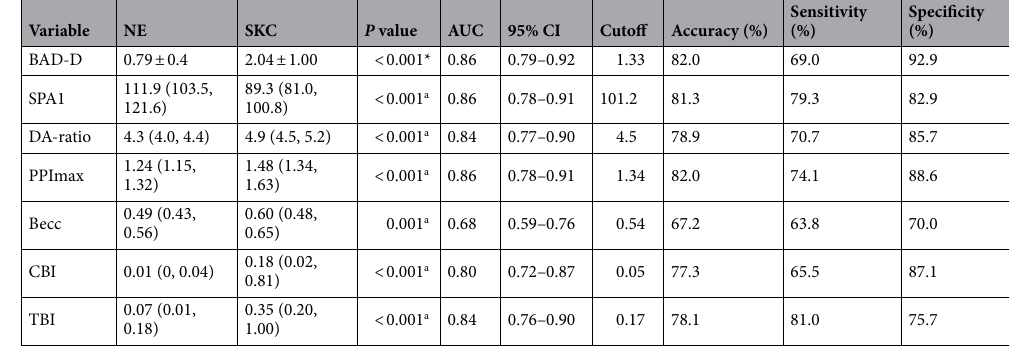
Table 3. Descriptive statistics of the key studied variables in the training-database. BAD-D Belin/Ambrósio Enhanced Ectasia Display Index, SPA1 stiffness parameter at first applanation, DA-ratio deformation amplitude ratio, PPImax maximum of pachymetric progression index, Becc eccentricity of back surface, CBI corvis biomechanical index, TBI combined tomography and biomechanical index; *Independent t-test. a Mann- Whitney U test.